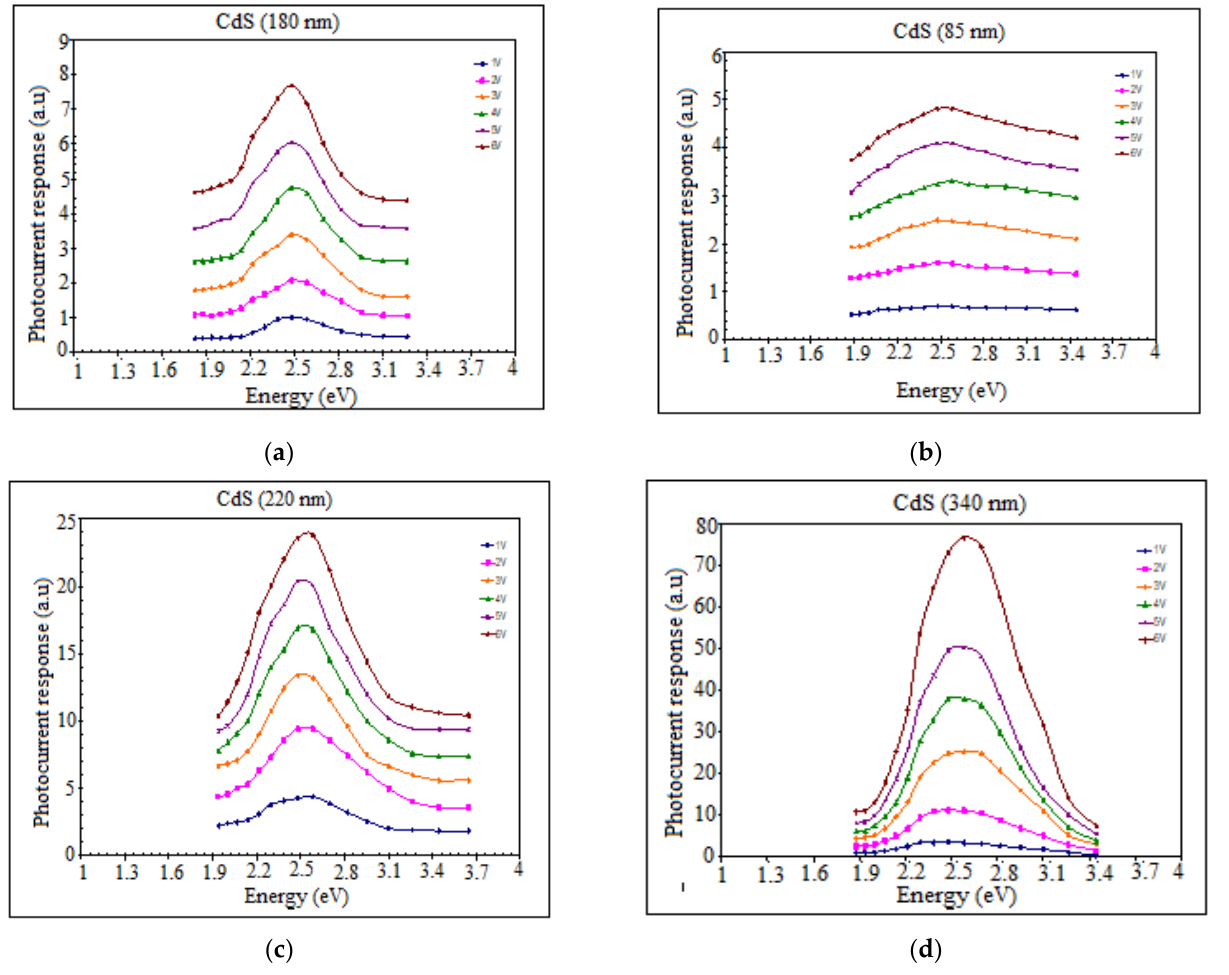
Figure 13. Photoconductivity response spectra at different bias voltage for CdS thin film with different thickness ( a ) 85 nm, ( b ) 180 nm, ( c ) 220 nm, and ( d ) 340